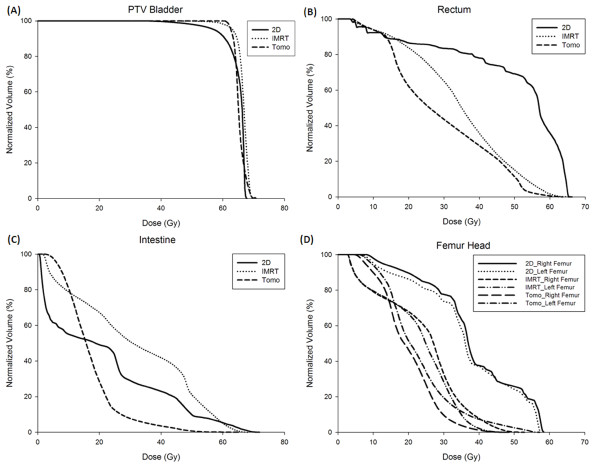
The comparisons of dose-volume histogram of planning target volume (PTV) and organs at risk for one of intensity-modulated radiation therapy (IMRT) - treated patients, one of helical tomotherapy (HT) - treated patients and one of the patients replanned by conventional box techniques (2DRT). (A) PTV. (B) Rectum. (C) Intestine. (D) Femur head.